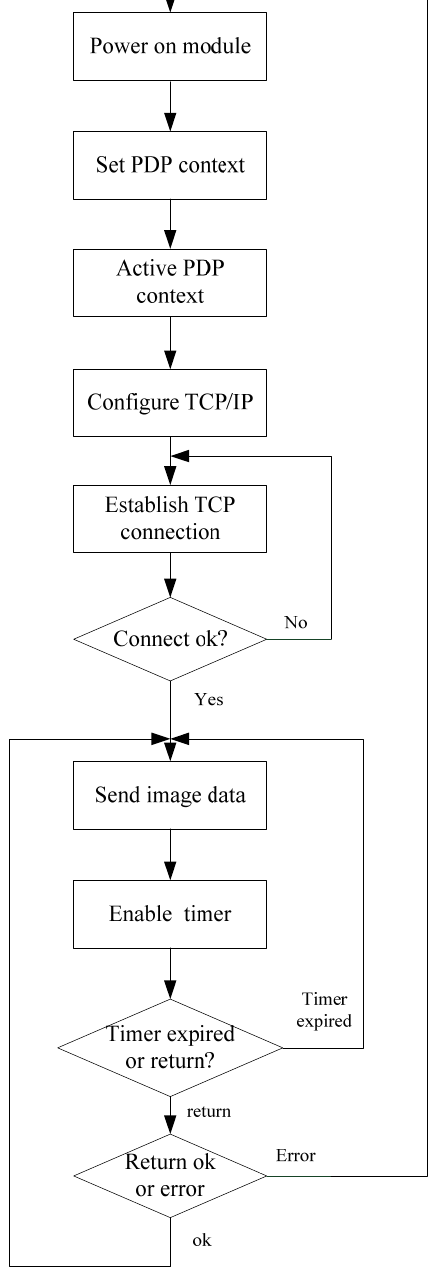
Figure 6. Wireless communication